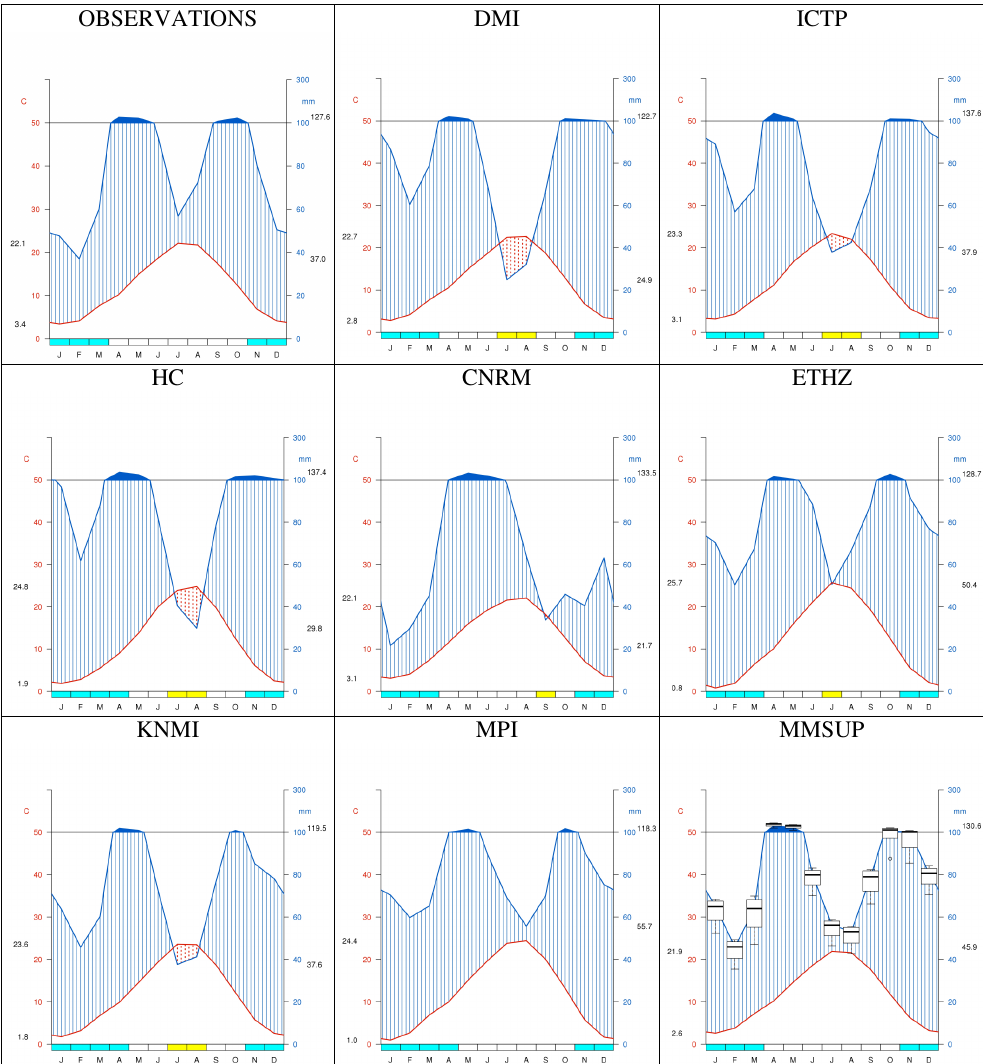
Fig. 7 : Walter and Lieth diagrams of the models and Multimodel (MMSUP) for the values averaged over Piedmont OI gridpoints, period 1981-2000. The yearly averaged bias was subtracted from each Fig. 7. Walter and Lieth diagrams of the models and multimodel (MMSUP) for the values averaged over Piedmont OI grid points, period monthly value. Multimodel uncertainty is represented as boxplots of the precipitation in the 1981–2000. The yearly averaged bias was subtracted from each monthly value. Multimodel uncertainty is represented as boxplots of the MonteCarlo experiment (5 th , 25 th , 50 th , 75 th , 95 th percentiles are shown). precipitation in the MonteCarlo experiment (5th, 25th, 50th, 75th, 95th percentiles are shown). to the mountains). Maximum temperatures during spring and summer increase more on the plains than in the